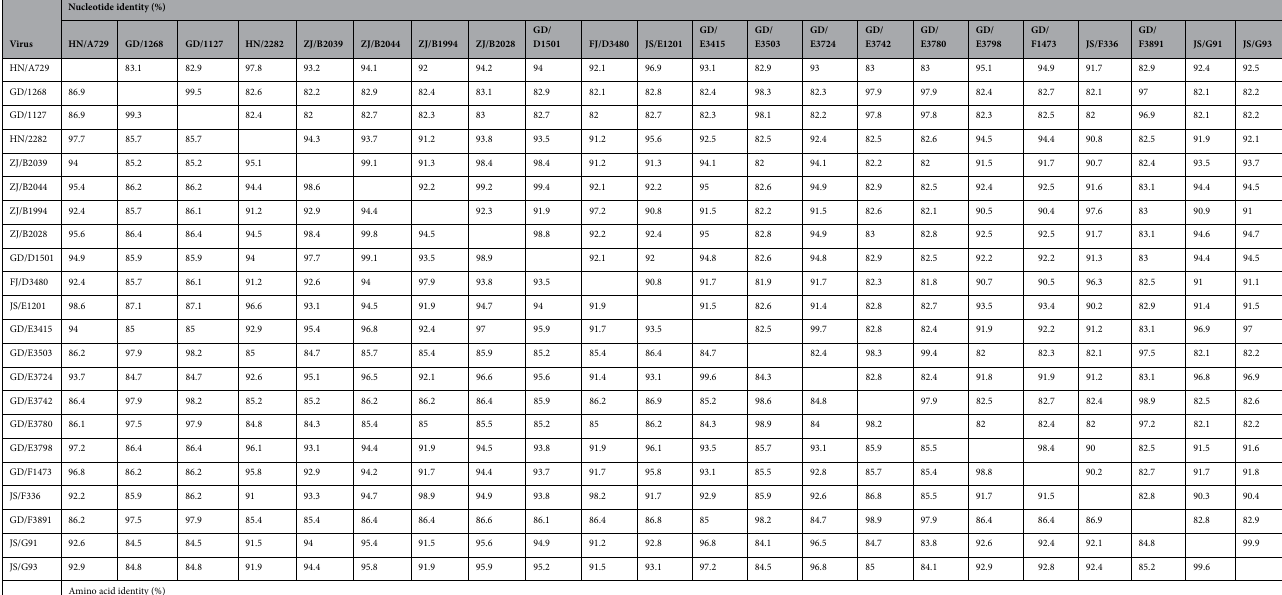
Table 3. Nucleotide and amino acid identity of the HA genes among the twenty-two H6 subtype isolates from Southern China,